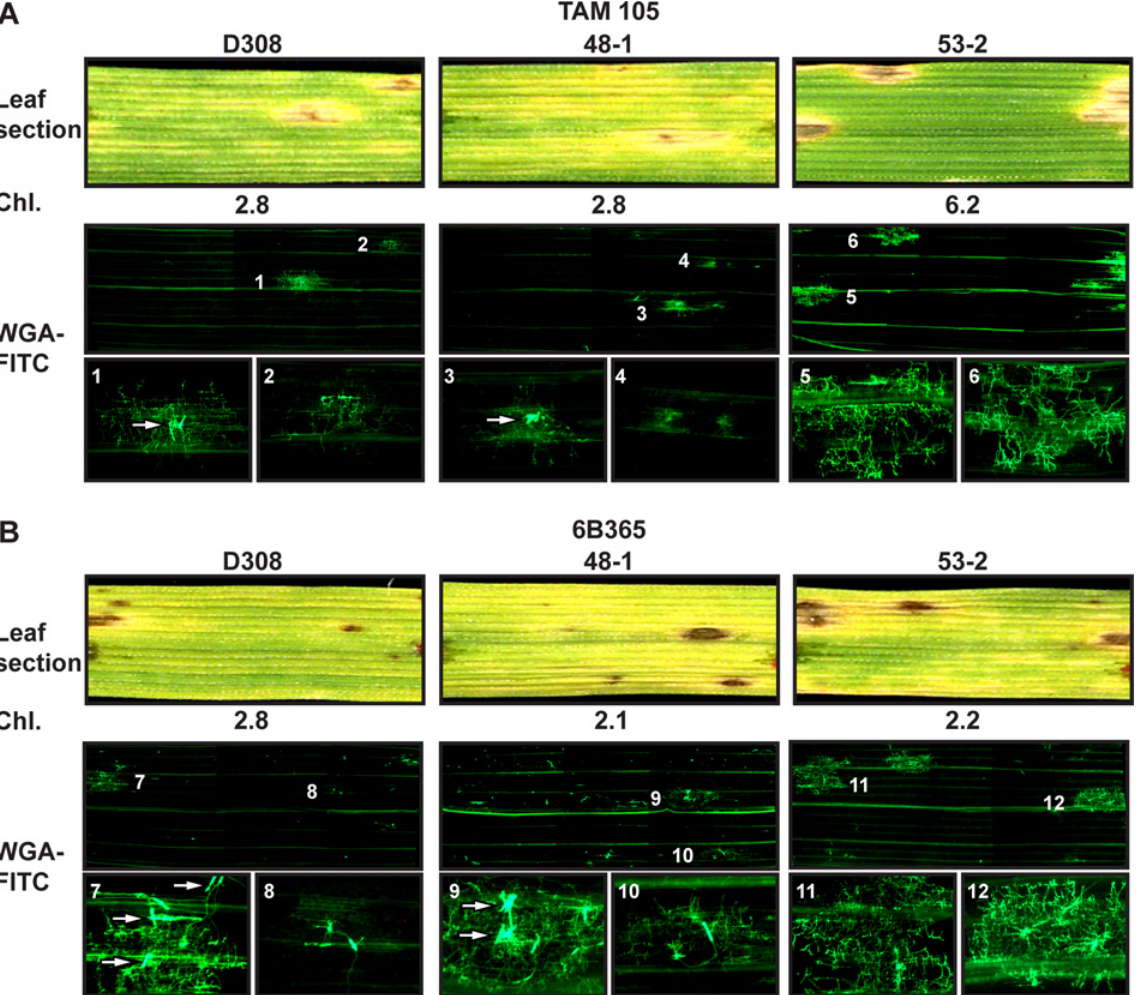
Fig 7. Mycelial growth in planta of D308 and D308 transformants. Isolates were inoculated on the ToxA- and ToxC-sensitive cultivars (A) ‘ TAM 105 ’ and (B) ‘ 6B365 ’ , respectively. One centimeter leaf sections harvested from inoculated leaves 6 days post inoculation were scanned (Leaf section), chlorophyll concentration estimated (Chl.), and mycelia stained with WGA-FITC. Stained leaves were imaged with a fluorescent microscope and the whole leaf image is a montage of 6 separate panels that cover the entire 1 cm leaf section. The bottom row represents increased magnification of the same size of select (numbered) lesions. Arrows point to multiple